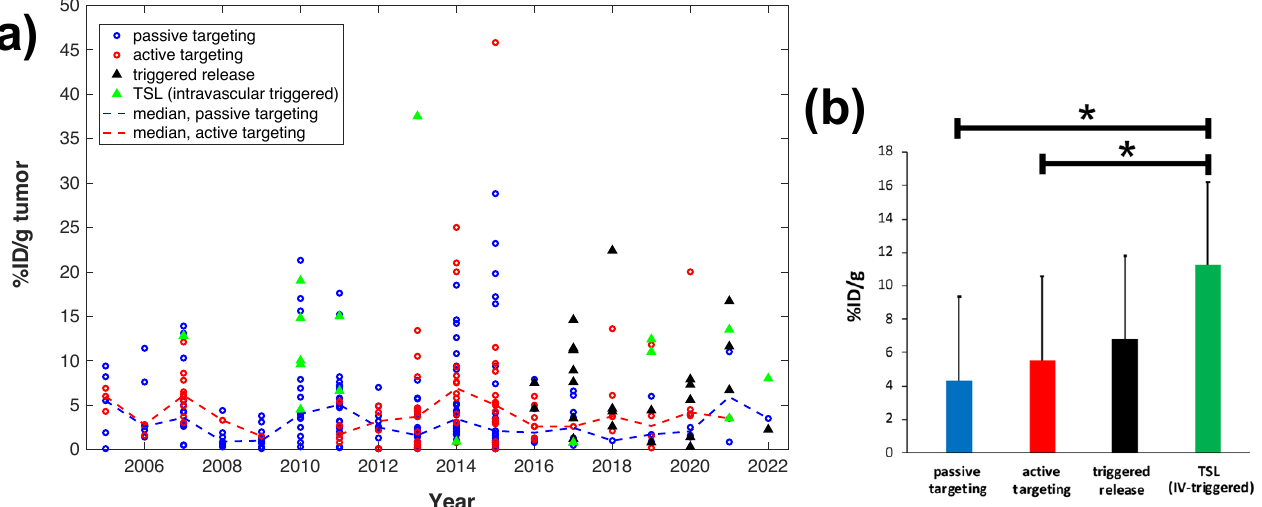
Figure 3. Delivery efficacy of intravascular triggered TSL compared to other nanoparticle DDS. A prior review compared the efficacy of 117 nanoparticle DDS studies published between 2005-2015 [27], and we combined data from this prior review to in-